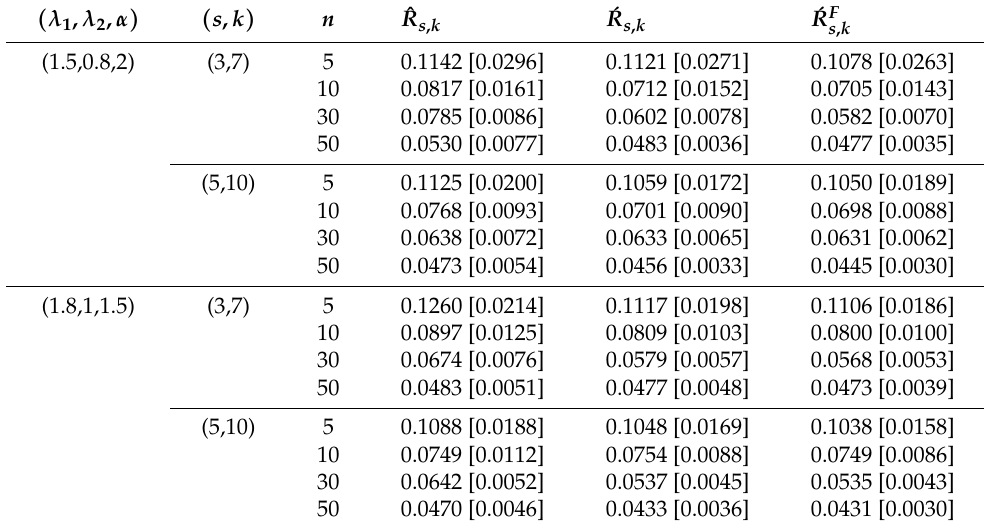
Table 1. ABs and MSEs (within bracket) for R s , k with common parameters.